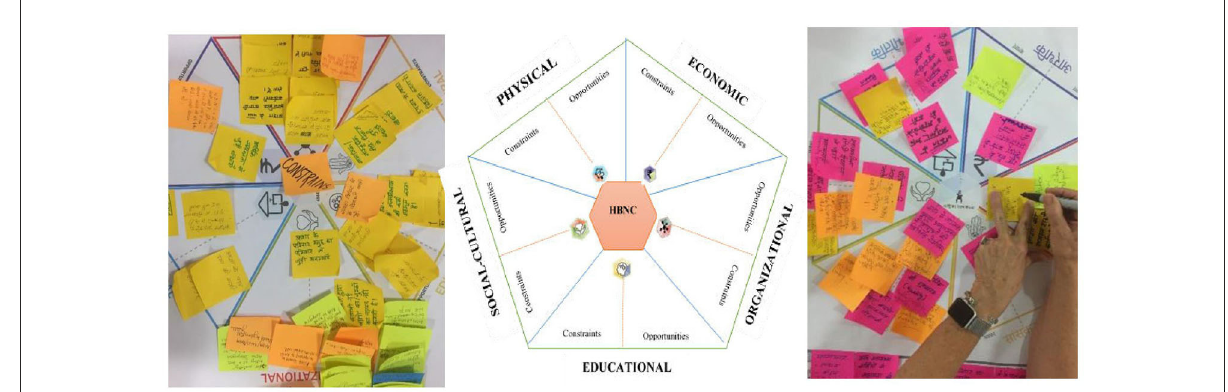
FIGURE3 Nexus chart.